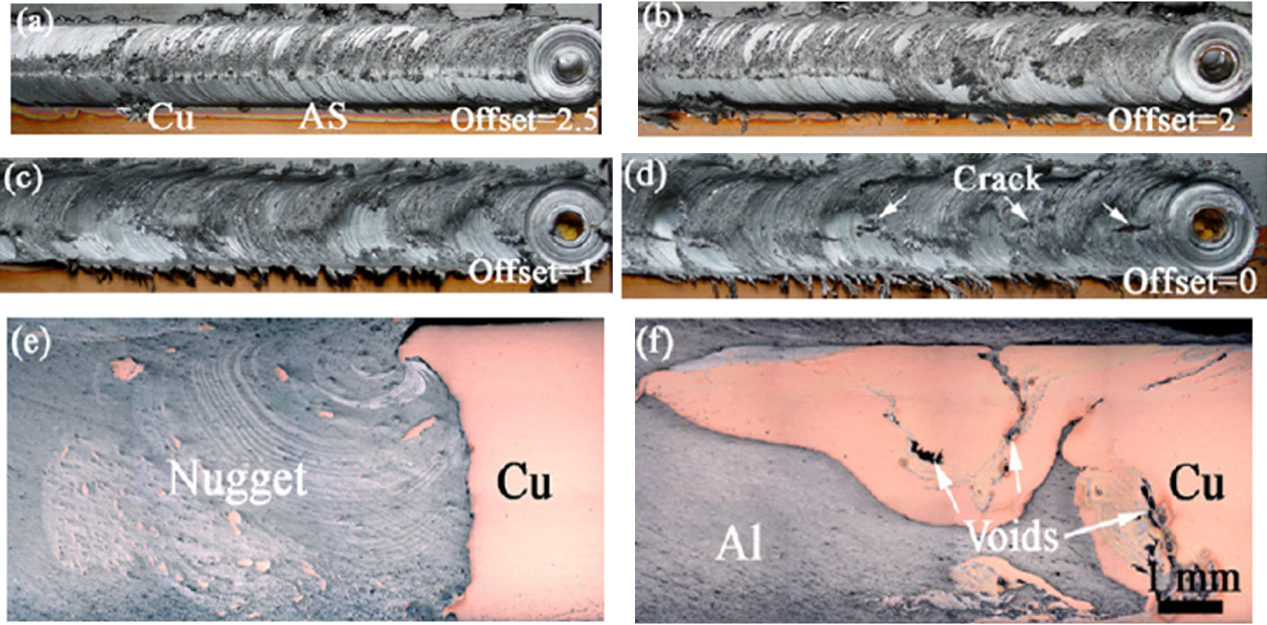
Figure 9. Surface morphologies of the FSW Al–Cu joints for pin offsets of ( a ) 2.5 mm; ( b ) 2 mm; ( c ) 1 mm; and ( d ) 0 mm. Cross ‐ sectional macrostructure of the joints for pin offset of ( e ) 2.5 mm and ( f ) 1 mm (adapted from [13], with permission from Elsevier, 2011).